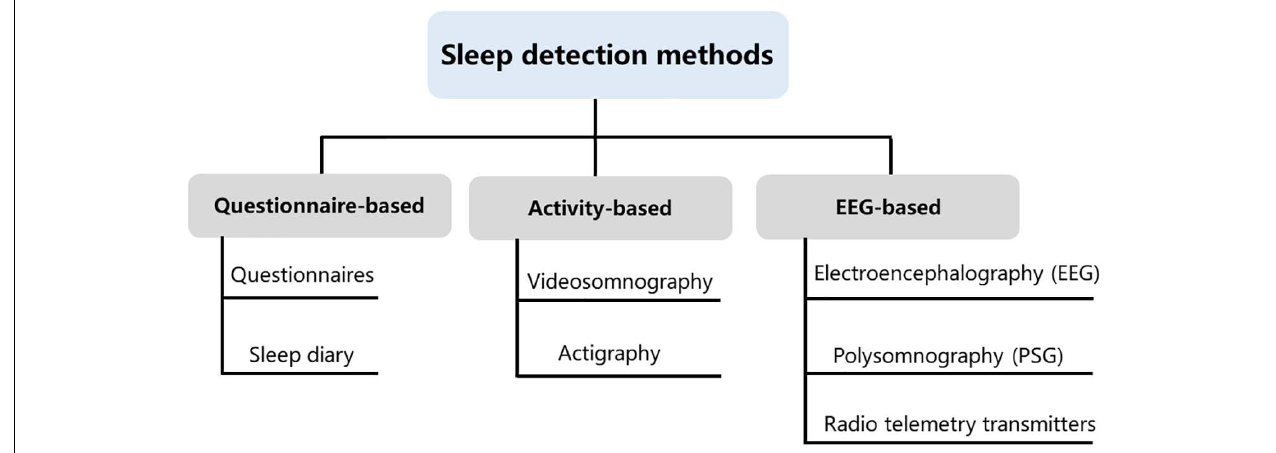
FIGURE 1 | Sleep detection methods. Current methods available for measuring sleep in young children include questionnaire-based, activity-based, and electroencephalogram (EEG)-based methods. These three types of assessments are not interchangeable, as each method contains its own idiosyncrasies that can influence the quality and meaning of the data that are